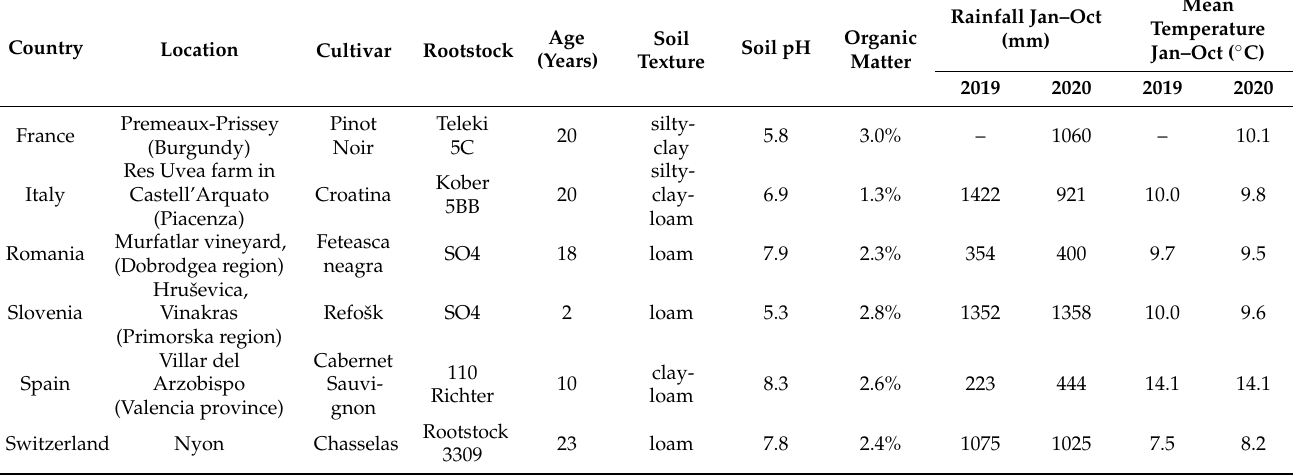
Table 1. Characteristics of the experimental vineyards from which the sown or native cover crop species samples were